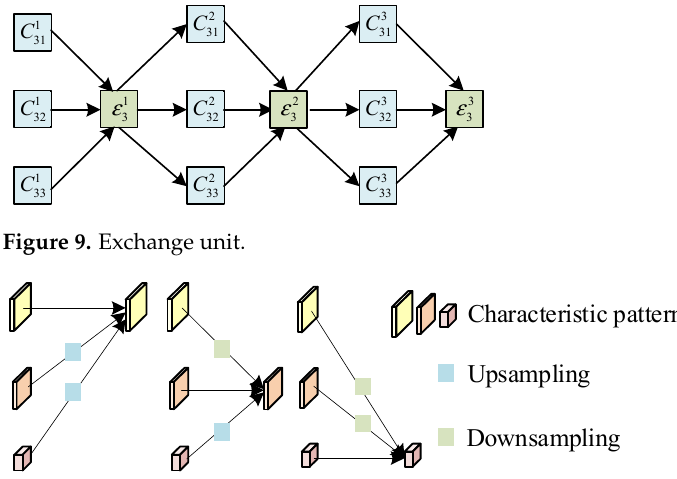
Figure 10. Multi-resolution feature fusion.